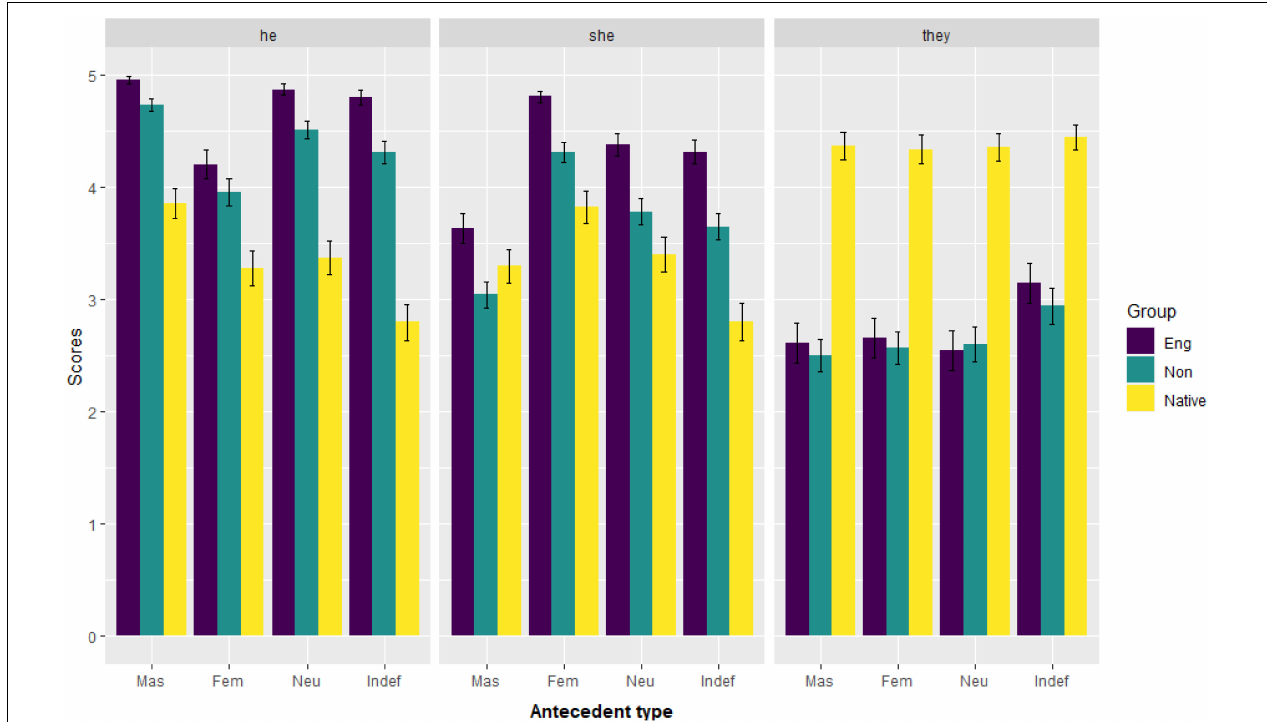
FIGURE 2 | Mean acceptability of each pronoun as a function of the antecedent type by each group. ( Eng , English majors; Non , non-English majors; Native , native English speakers; Mas , masculine; Fem , feminine; Neu , neutral; Indef , indefinite).